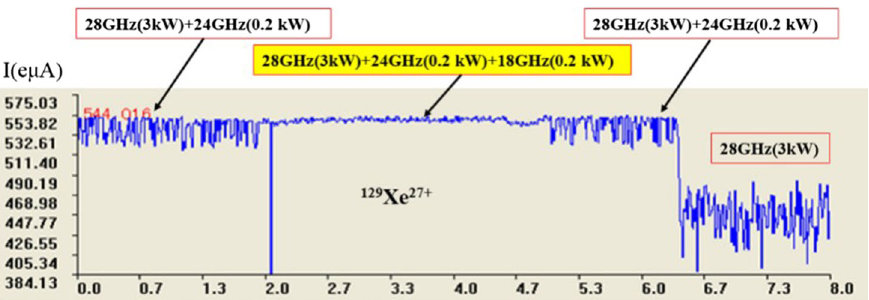
FIG. 26. Suppression effect of beam instabilities by two-frequency heating ( 28 þ 24 GHz) and three-frequency heating ( 28 þ 24 þ 18